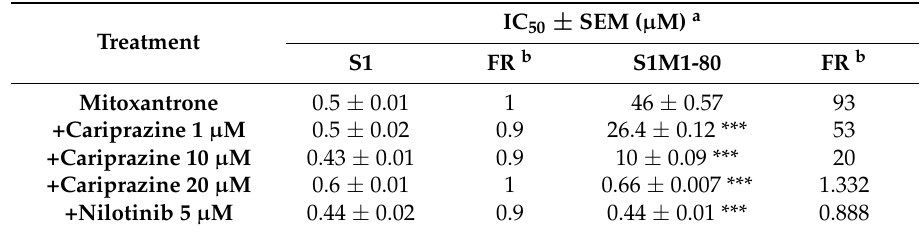
Table 2. The effect of cariprazine and nilotinib on the cytotoxicity of MX in ABCG2-overexpressing S1M1-80 cells.